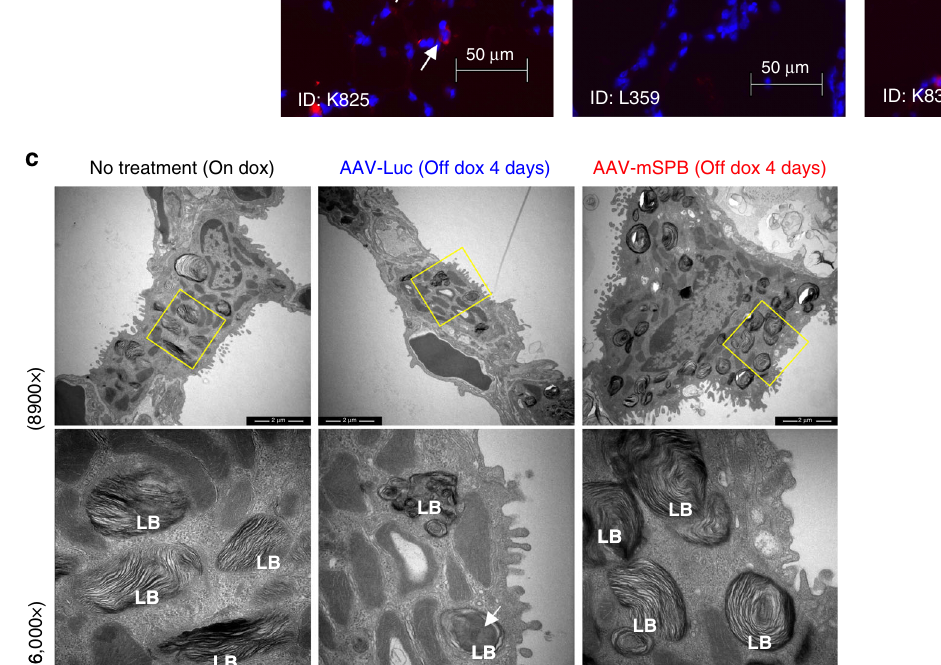
Fig. 5 AAV-mSPB restores SP-B expression and maintains lamellar body structure. a Gross lung images from 2 AAV-mSPB treated mice 60 days following dox removal. The yellow arrow indicates a region of lung damage. b Representative epi fl uorescence images of proSP-C (green), SP-B (red), and DAPI (blue) from frozen lung sections of a mouse on dox; an untreated mouse off dox for 9 days; and a 10 11 vg AAV-mSPB treated mouse off dox for 60 days. The white arrows indicate SP-B staining (Scale bar, 50 μ m). c Representative transmission electron microscope images of AT2 cells 4 days following dox removal. Magni fi ed images (36,000×) of lamellar bodies (LB) are indicated by the yellow boxes on the 8900× images. The white arrow indicates the accumulation of amorphous material within the lamellar body (LB) of an AT2 cell from an AAV-Luc lung (Low magni fi cation image scale bar, 2 μ m; High magni fi cation image scale bar, 500